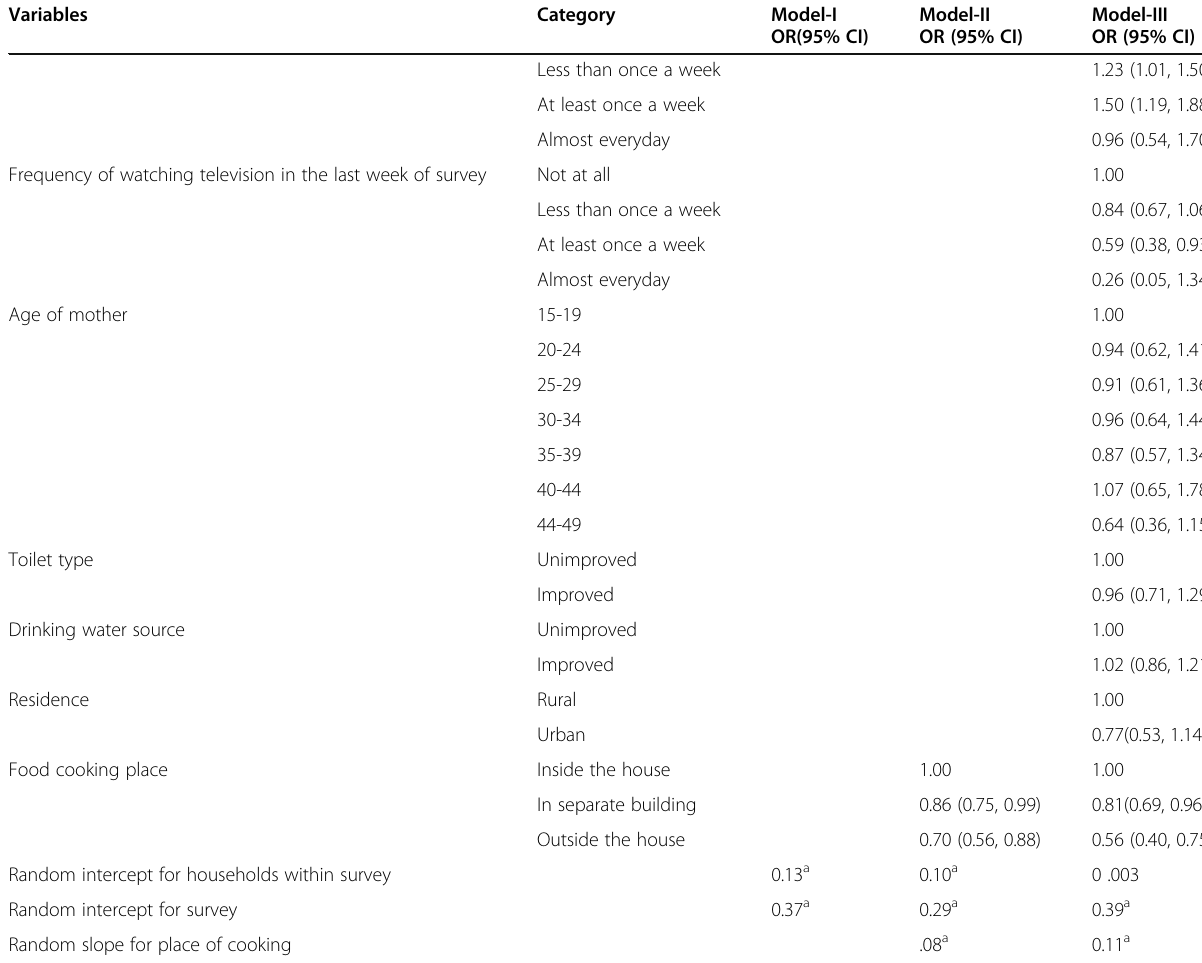
Table 3 Multilevel logistic regression on the association of food cooking places with ARI in under-five children in controlling other variables, EDHS, 2005 – 2016 (Continued)